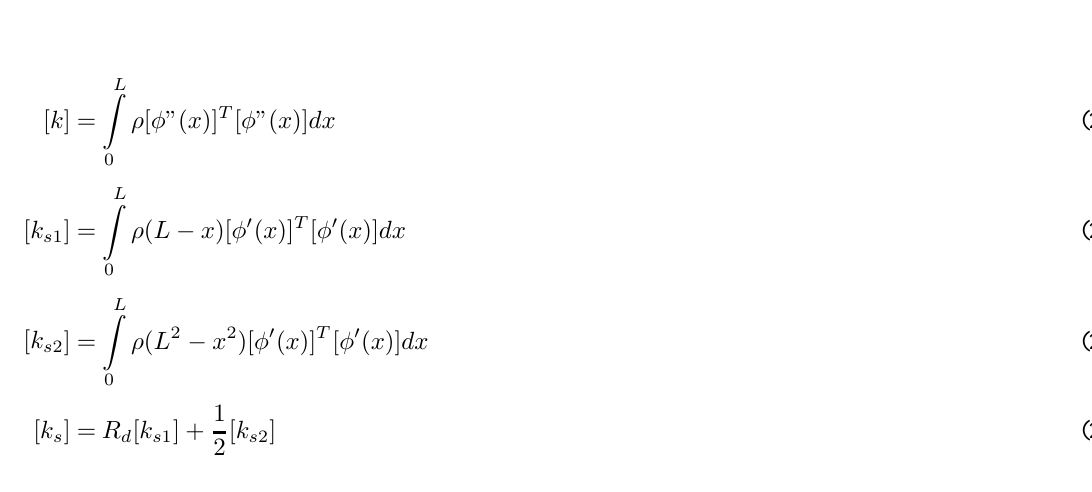
Fig. 7. Natural Frequencies as function of shaft torsional stiffness M D for rotating speeds: ω = 0, 50, 100, 150